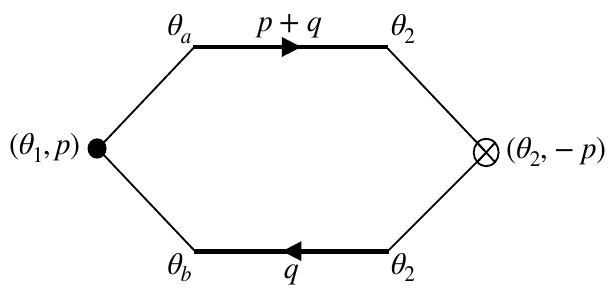
Figure 3 . The full J 0 2 point function is obtained by connecting the exact J 0 -vertex (solid circle) to the free vertex (cross) with exact propagators (thick